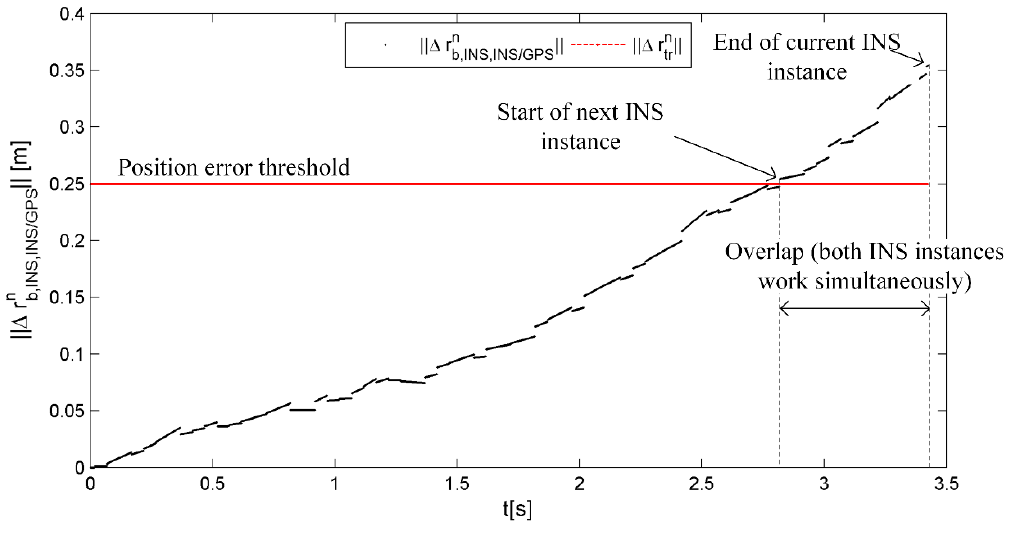
Figure 4. INS instance (no 1) position error in flight no 1.